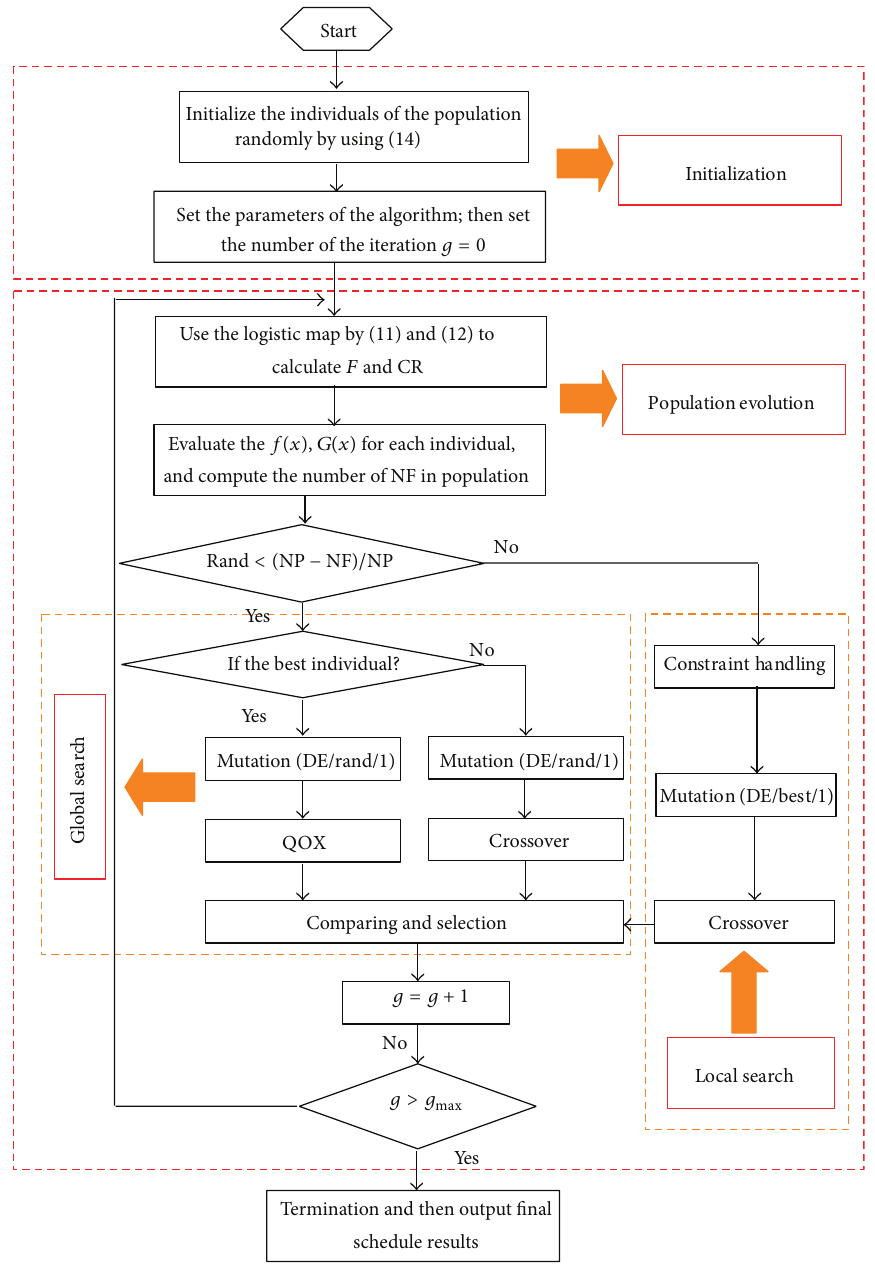
Figure 2: The flow chart of